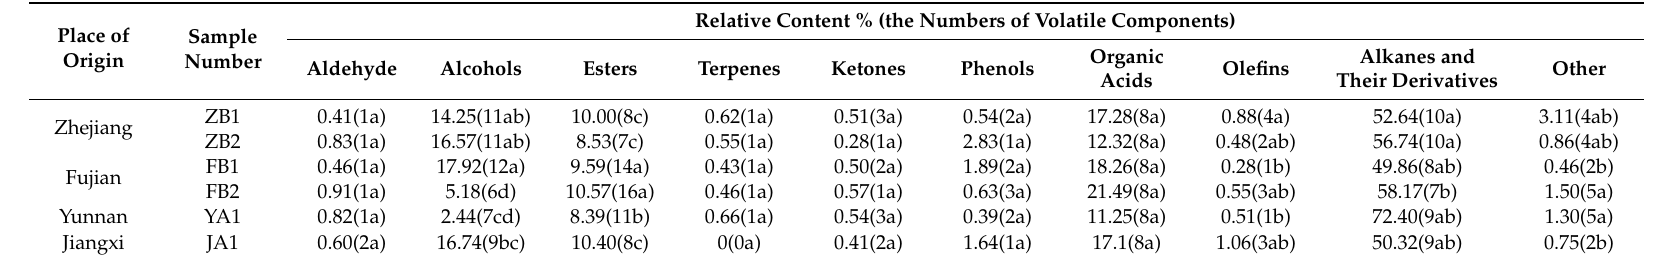
Table 1. Categories and relative contents of volatile components in Dendrobium o ffi cinale from di ff erent